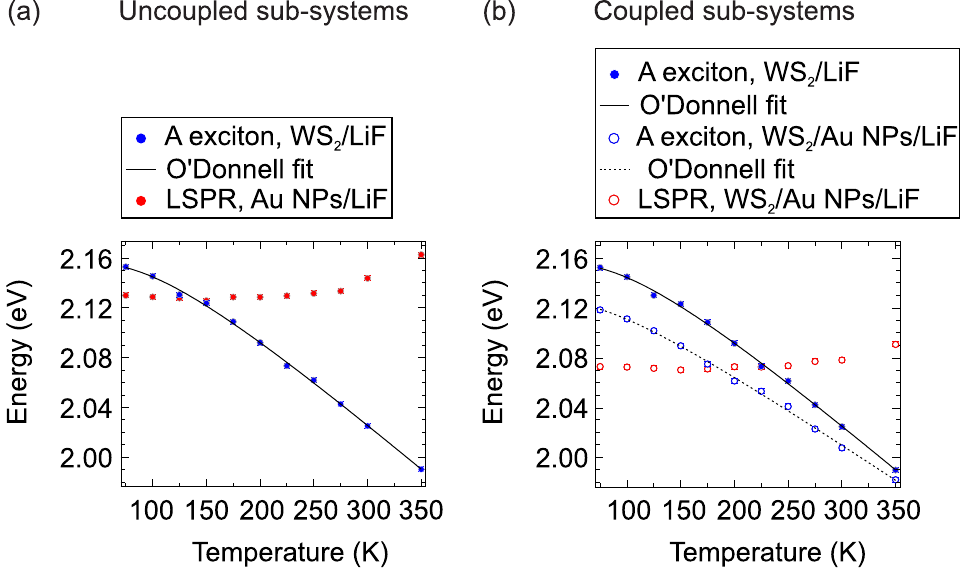
Figure 4. ( a ) Trend as a function of temperature of the energy position of the A exciton in ML-WS 2 /LiF (filled blue circles) and of LSPR in Au NPs/LiF (filled red circles). The continuous black line is fit to the A exciton energy by using the O’Donnell model [65]. ( b ) Trend as a function of temperature of the energy position of the A exciton (open blue circles) and of the LSPR of Au NPs (open red circles) in the WS 2 /Au NPs/LiF heterostructure. The A exciton energy of the ML-WS 2 /LiF sub-system (filled blue circles) is reported for comparison. Both solid and dashed black lines are fitting curves of the A exciton energy by using the O’Donnell